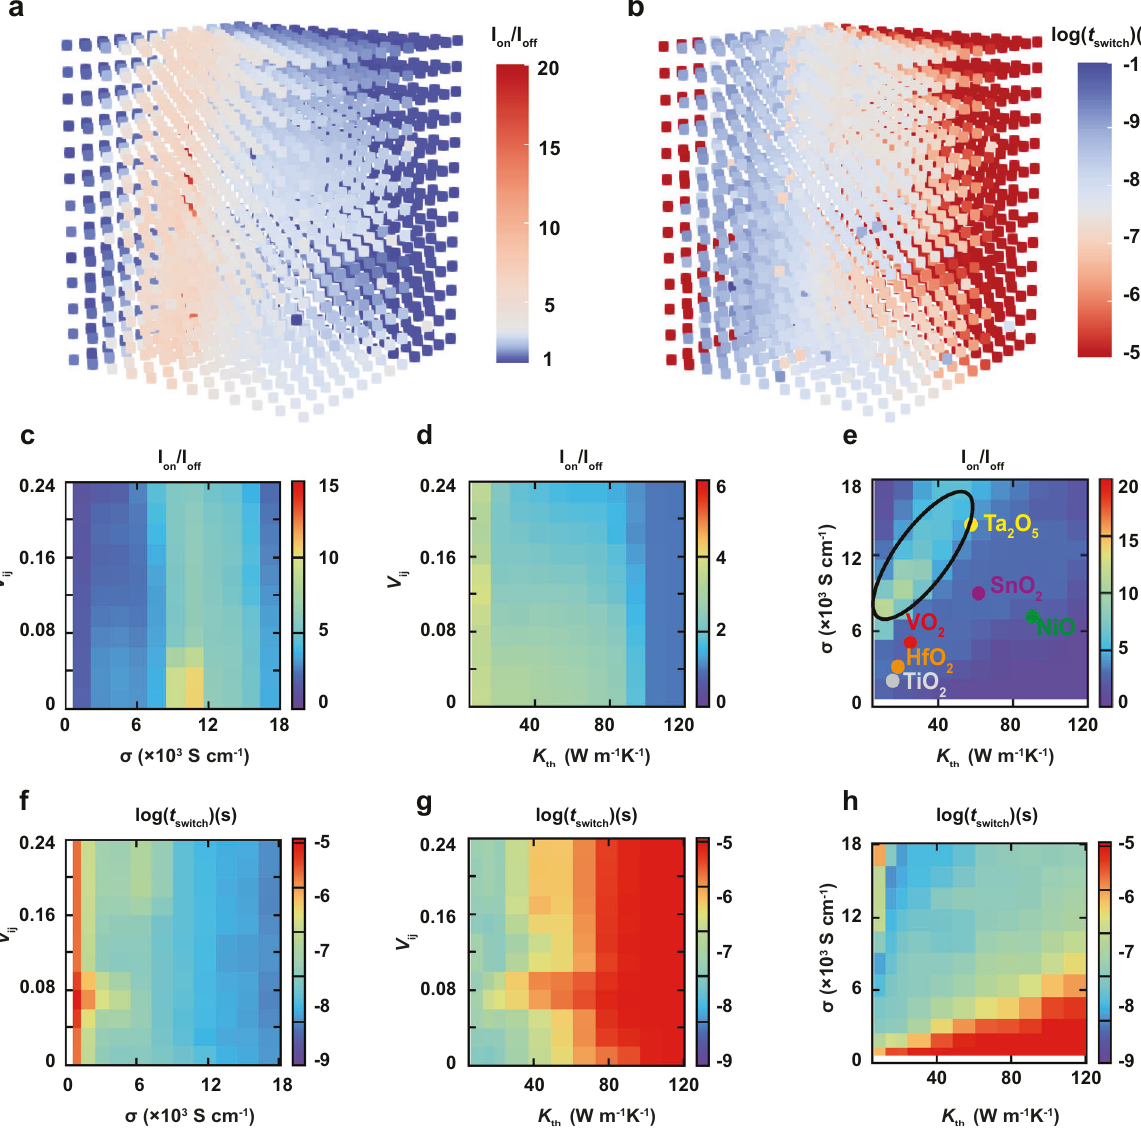
Fig. 4 High-throughput phase- fi eld simulations. a The current on/off ratios ( I on / I off ) and b the resistive switching time ( t switch ) for metal oxides-based RRAM by parameterizing the three characteristic materials constant, i.e., the Vegard strain coef fi cient ( V ij ), electrical conductivity ( σ ) and thermal conductivity ( k th ). 2D mapped I on / I off c – e and t switch f – h as a function of two out of the three materials parameters ( V ij , σ , k th ) at a fi xed remaining